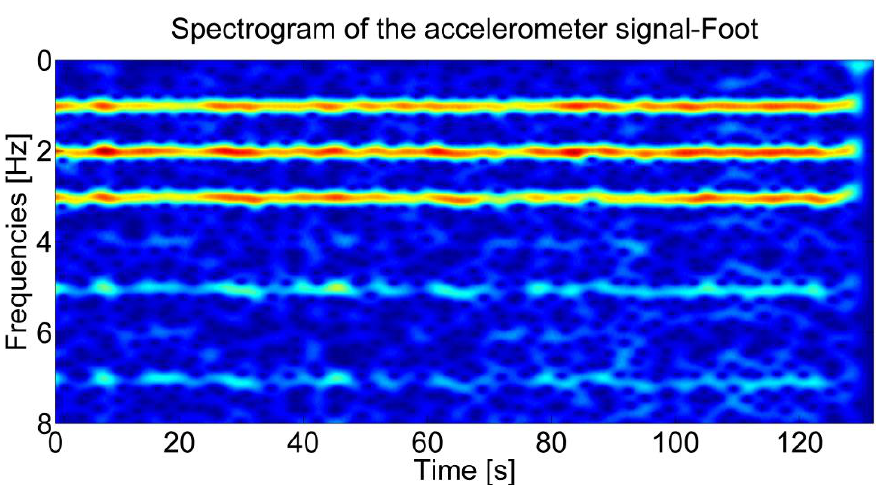
Figure 1. Spectrogram of the accelerometer signal for the sensor mounted on the walking user’s foot.